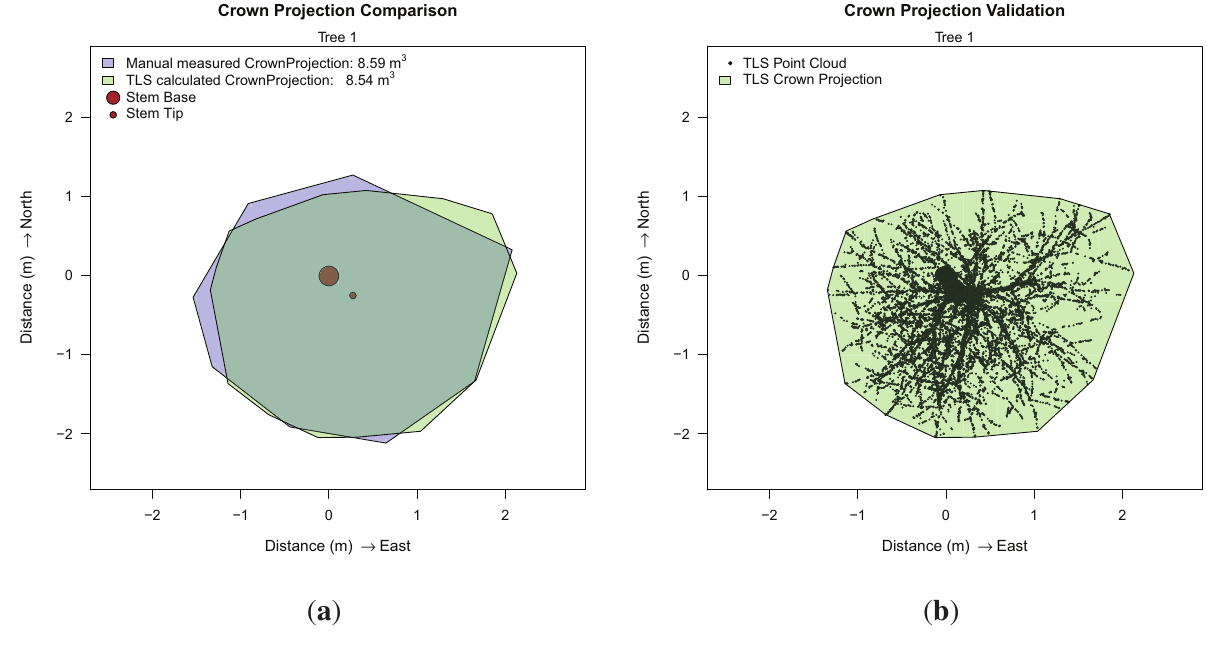
Figure 8. Crown projection analysis for Tree 1: (a) comparison to manual results; (b) in the x , y -plane projected point cloud as visual